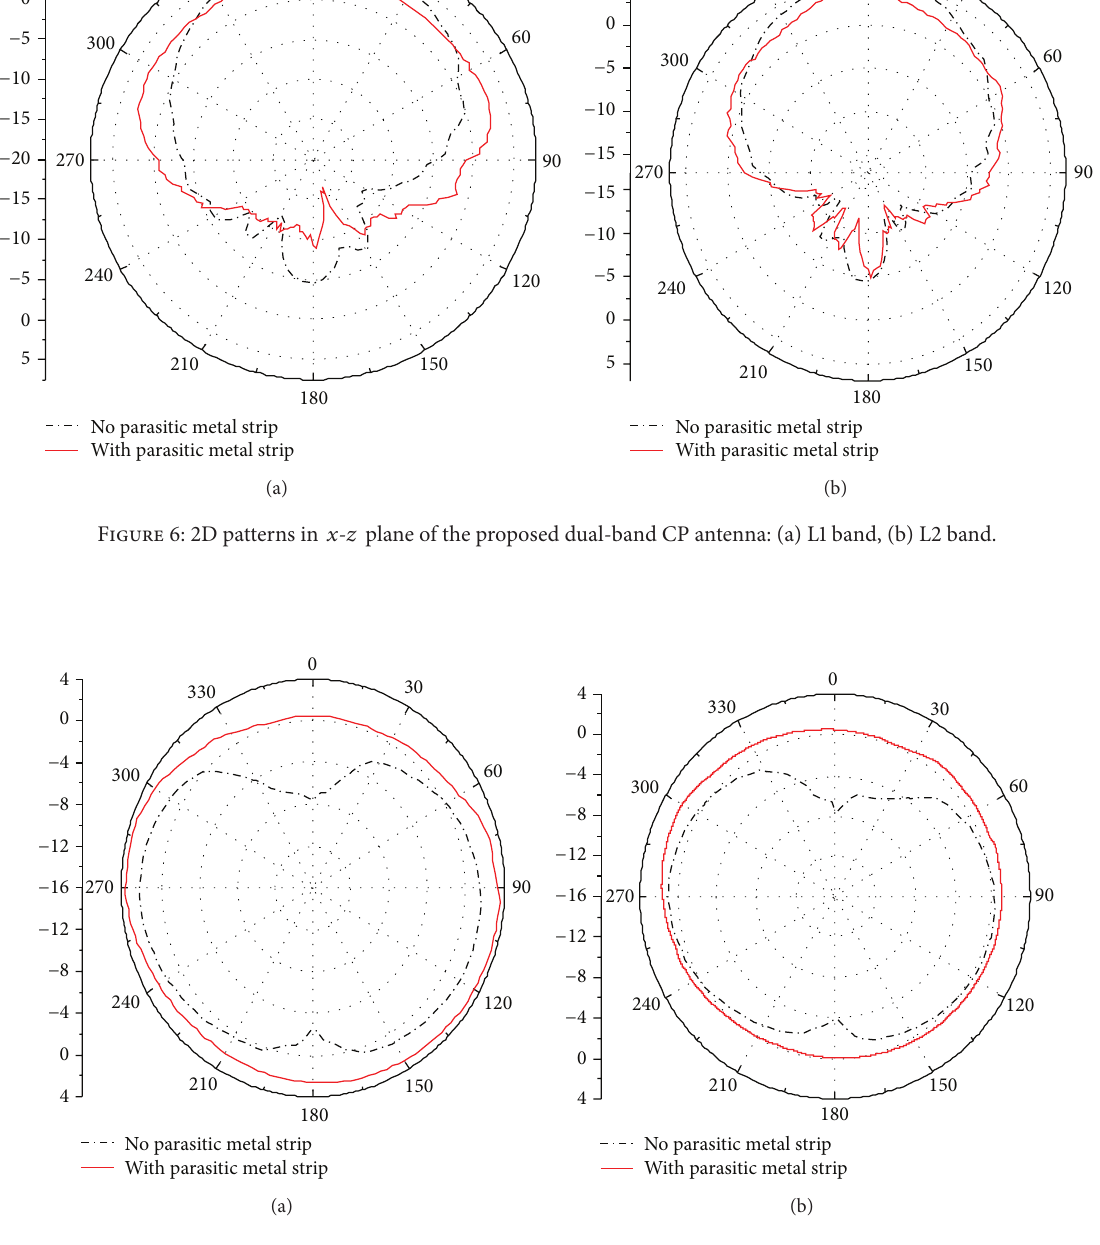
Figure 7: 2D patterns in 𝑥 - 𝑦 plane at 𝜃 = 70 ∘ of the proposed dual-band CP antenna: (a) L1 band, (b) L2